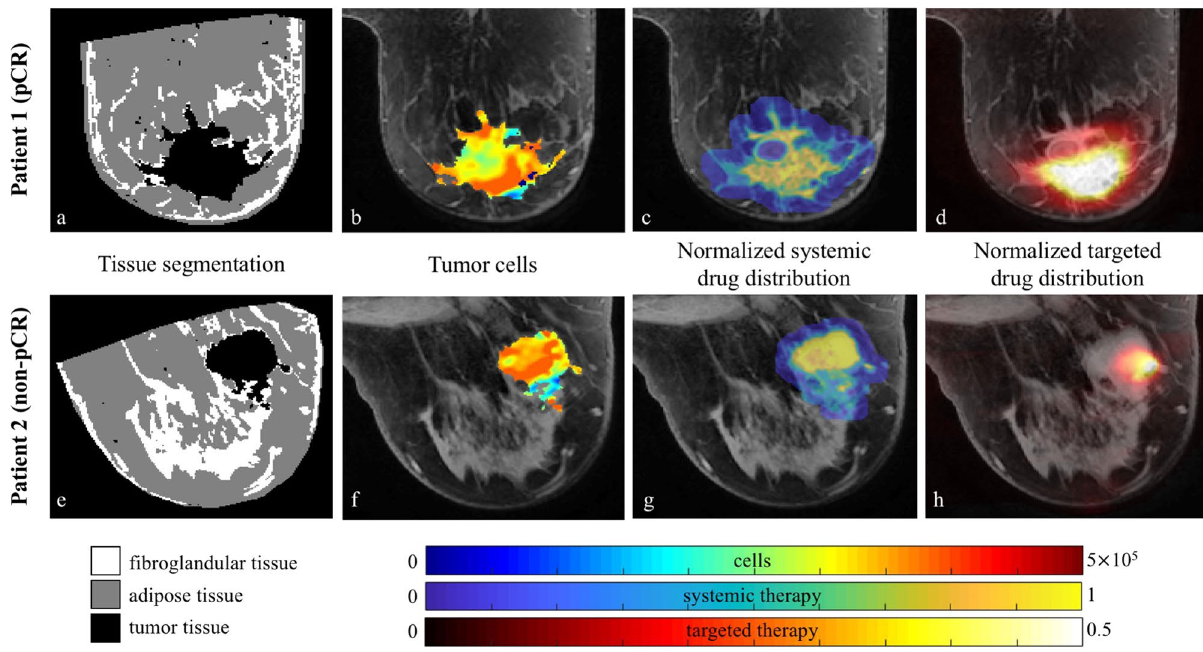
Figure 4. The central slide of each tumor for both patients are shown to depict the tissue segmentation ( a , e ), number of tumor cells ( b , f ), and the normalized estimates of the systemic ( c , g ) and targeted ( d , h ) therapies used in the model. The tissue segmentation identifies the tumor (dark area), fibroglandular (white), and adipose (grey) tissues within the breast. For the remaining columns, the parameter maps (i.e., the colored pixels) are overlaid on anatomical images of the breasts (grey). At surgery, patient 1 was designated as a pCR, while patient 2 had residual disease and was designated as non-pCR. Both patient’s tumor exhibit areas of high cellularity, and the approximate drug distribution of the systemic therapies have similar intensities. Comparing the targeted distribution maps, patient 1 appears to have had greater drug distribution compared to patient 2 for this central